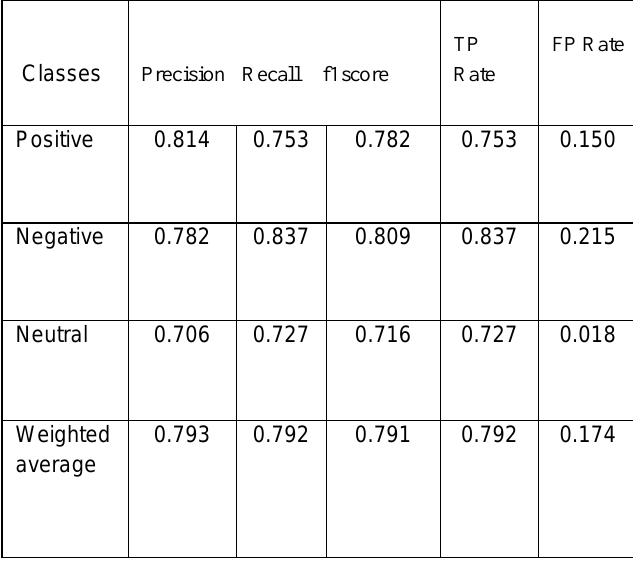
Table 5 shows the correctly and incorrectly predictions made by proposed Naïve Bayes classifier with Bag of noun approach. There are also same instances used 279 positive, 288 negative, 33 neutral.